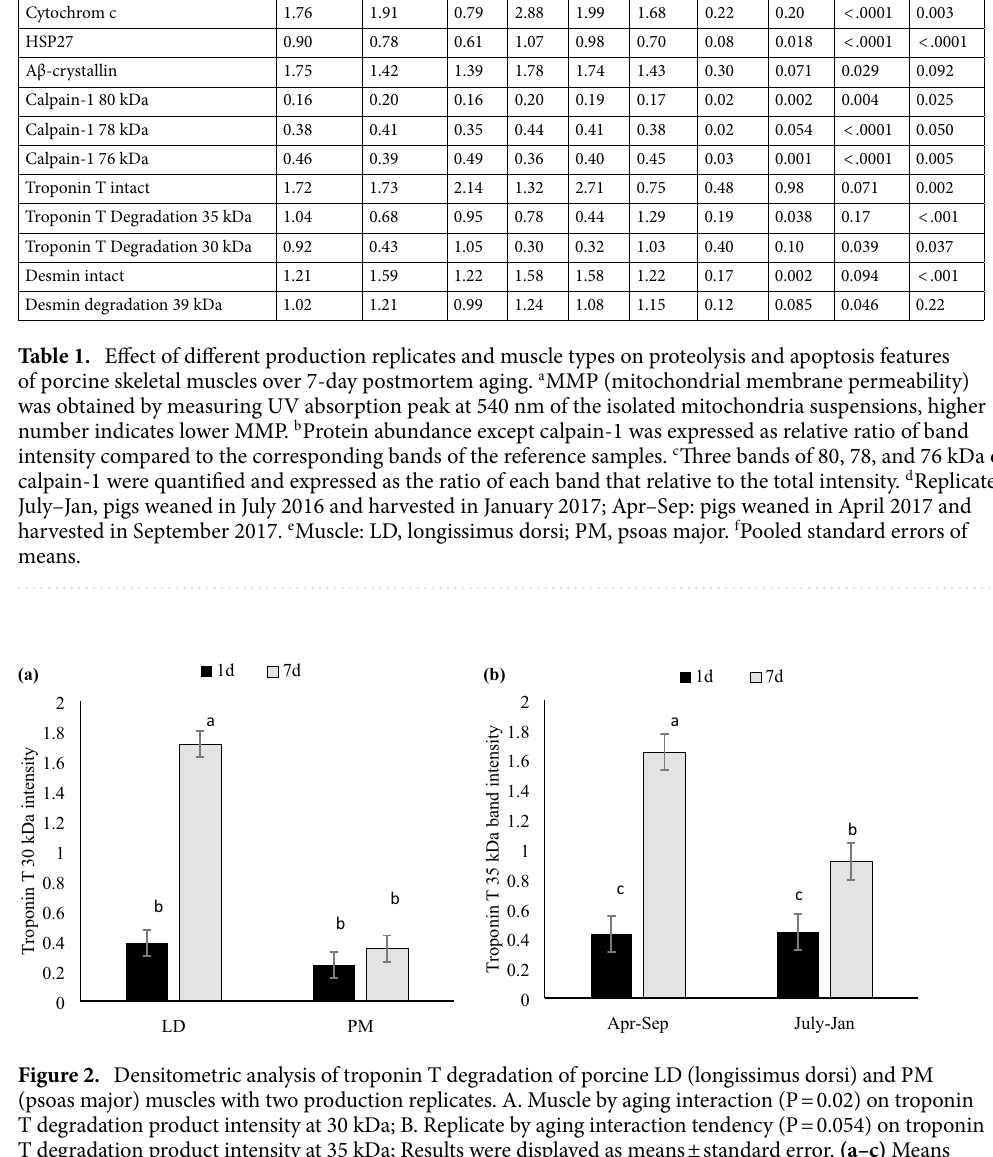
degradation compared to LD. Even though PM had further degradation, the overall abundance was higher in PM, regardless of aging time, which was corroborated with αβ-crystallin. Metabolomics analysis. Metabolomics profiling of LD and PM samples from both production replica- tions were obtained using GC-TOF–MS/MS platform with multivariate statistical analysis. The PCA score plots indicated that all experimental groups were notably different from each other, as it showed separation of LD vs. PM muscles from July–Jan vs. Apr–Sep groups (Fig. 4a). The samples primarily separated according to muscle type along the first principal component (PC1), which explained 25.9% of the total variance of the model. In addition, PC2 could explain 12.3% of the total variance of the data set, which separated July–Jan and Apr–Sep muscle samples (Fig. 4a). While the PLS-DA score plot showed a pattern similar to PCA score plots, this model was used to identify metabolites that differentially presented between muscle and/or production replicate groups (Fig. 4b, R 2 X = 0.559, R 2 Y = 0.981, Q 2 = 0.835, P < 0.05). Overall, the first and second PLS component (PLS1 and PLS2) accounted for